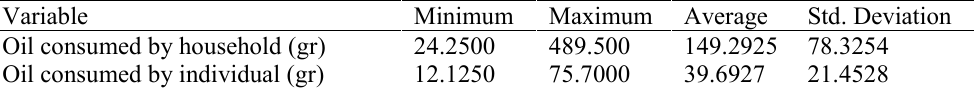
Table 2. Amount of consumed oil per household and household members in 24 hours